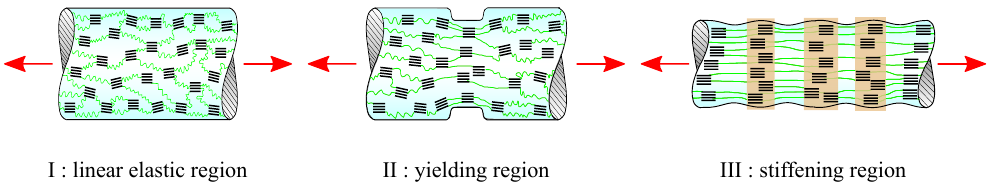
Figure 4. Schematic representation of the movement of crystalline units in the fiber model during